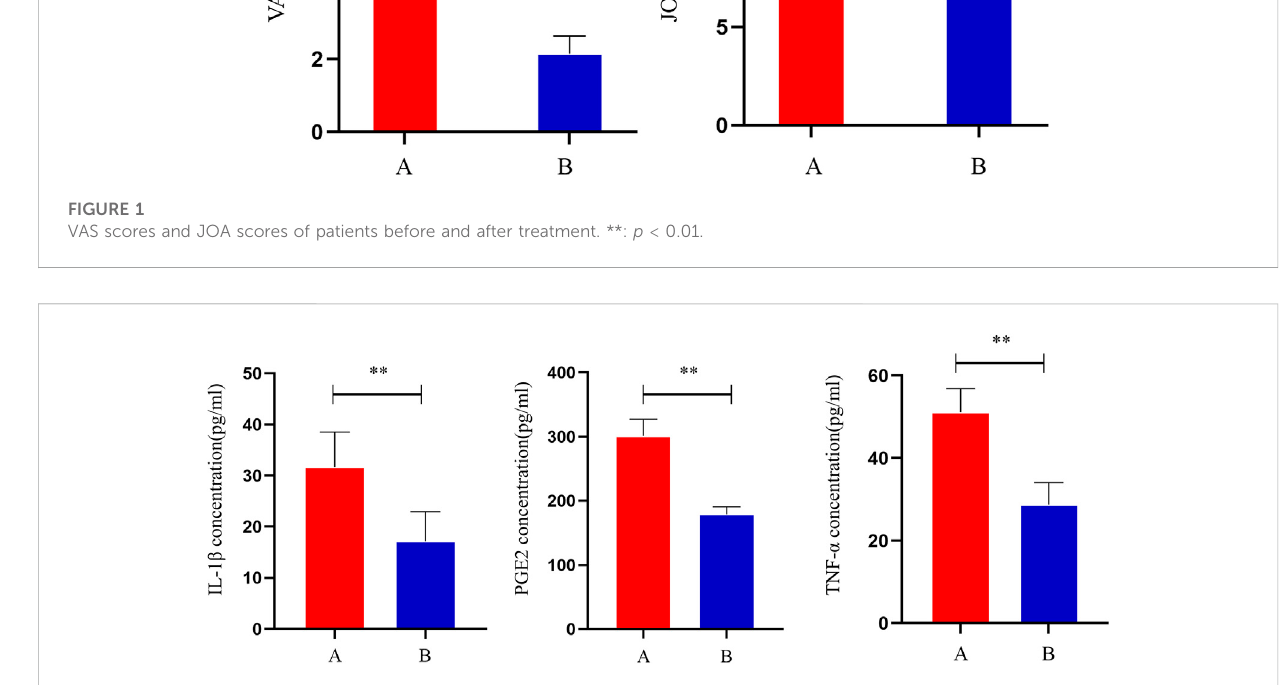
FIGURE 2 Changes in serum levels of IL-1 β , TNF- α and PGE2 in patients before and after treatment. **: p <